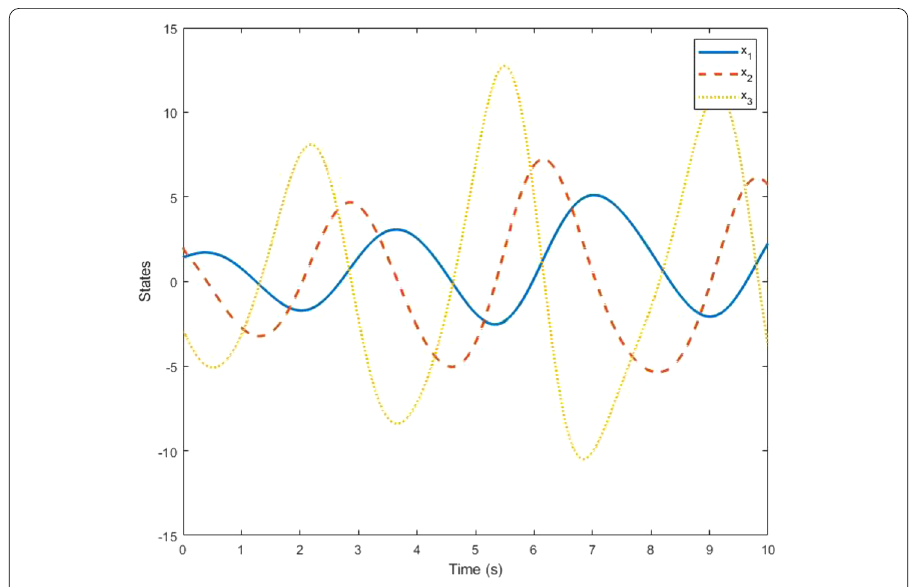
Figure 1 Chaotic behavior of the uncontrolled Arneodo